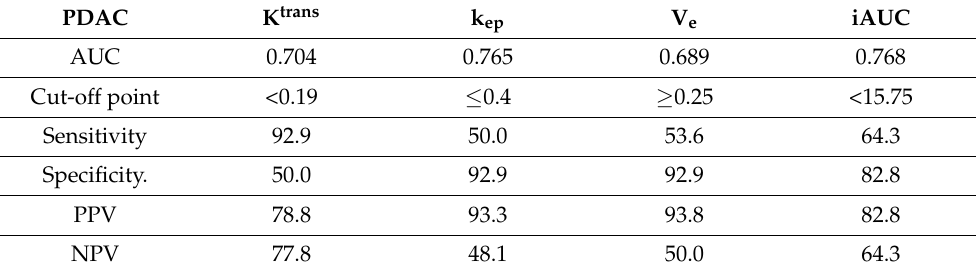
Table 3. Average of Ktrans, Kep, Ve, and iAUC in the presence of PDAC.